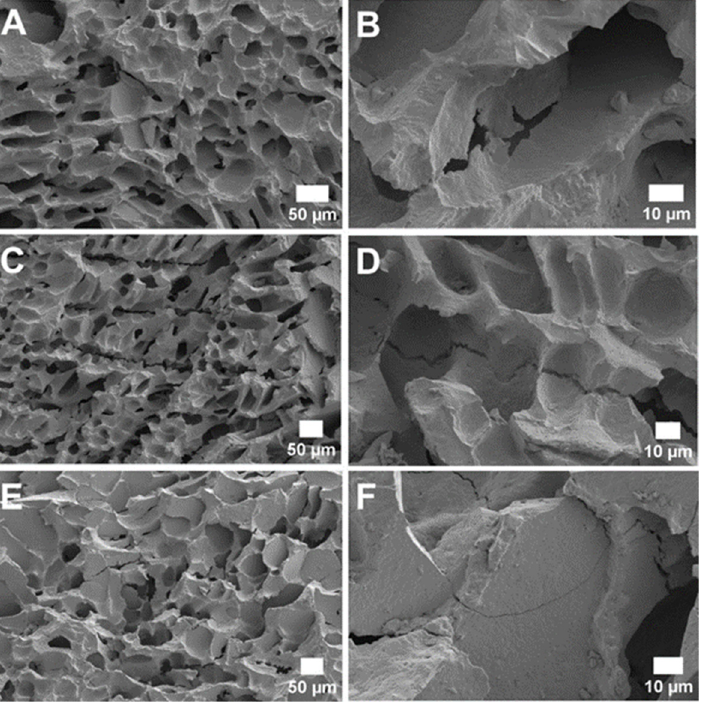
Figure 5. SEM micrographs of the surface of thermally shocked YSZ beams tested at